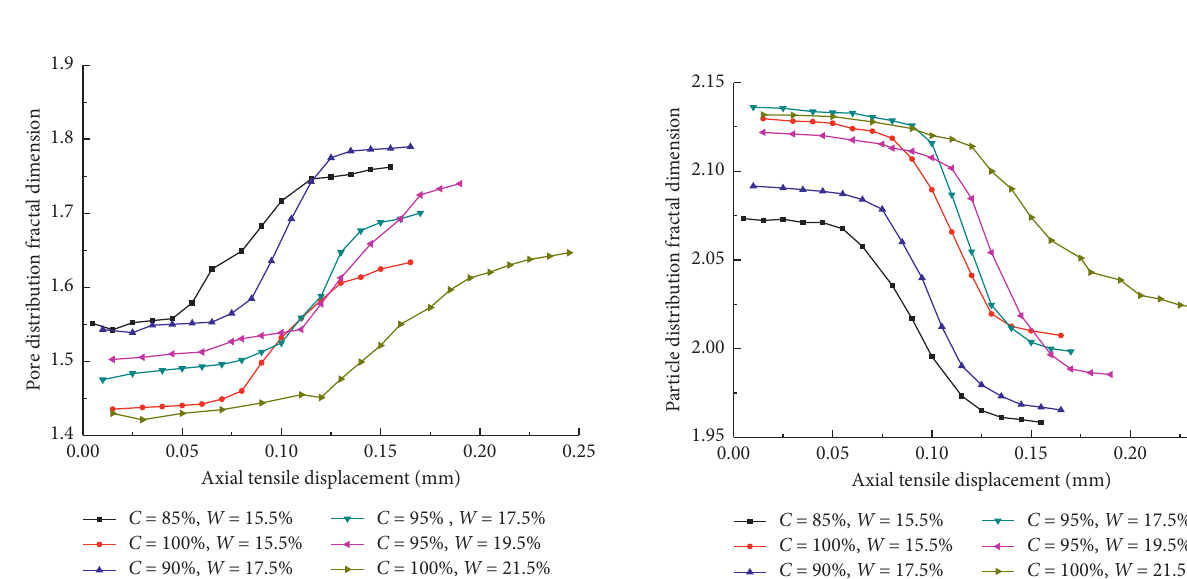
Figure 20: The change of particle orientation in Zone 1.